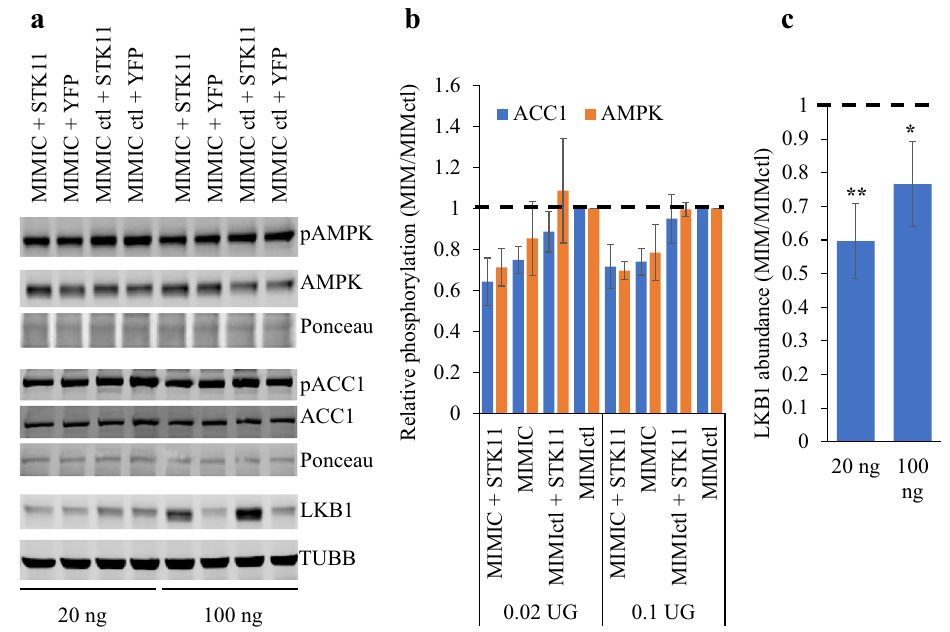
Figure 7. Exogenous LKB1 is insufficient for AMPK phosphorylation recovery and is sensitive to miR1908-5p. HuH-7 cells (24 well plate) treated either with a miR1908 mimic or a control mimic were transfected with 20 or 100 ng of pHAGE-STK11 (or PLVX-YFP) and analyzed by western blot with the indicated antibodies. Ponceau shown represent the regions matching the AMPK (50–60 kDa) and ACC1 (250 kDa) signals. ( a ) representative Western blots (3 distinct gels, with matching Ponceau or TUBB signal). ( b ) quantification of relative phosphorylation from 2 independent determinations, normalized to the MIMIC ctl value (± S.D.); 20 ng plasmid resulted in a 12% LKB1 increase while 100 ng yielded a 3.2-fold increase (over matching YFP control). ( c ) recombinant LKB1 is affected by miR1908-5p. LKB1 levels were measured relative to TUBB in 4 distinct experiments performed as in ( b ). Bars represent the relative LKB1 abundance, expressed as the MIMIC LKB1/ TUBB value over the corresponding MIMICctl value. MIM vs MIMctl: * p < 0.05; ** p <